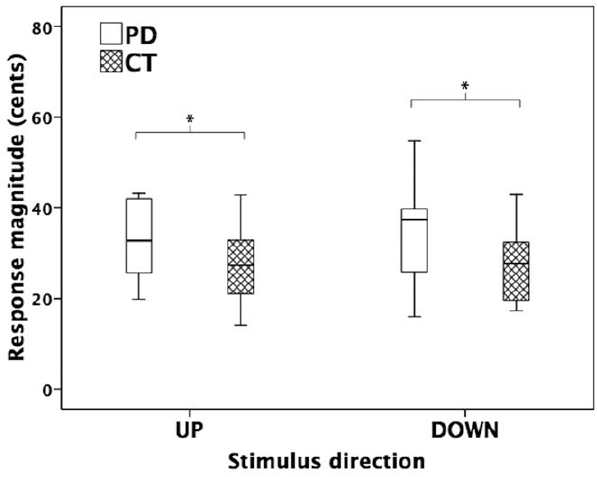
Figure 6. Box plots illustrating the voice F 0 response magni- tudes as a function of stimulus direction for the control group (cross-hatched boxes) and the PD group (blank boxes). The asterisks indicate significant differences between conditions.